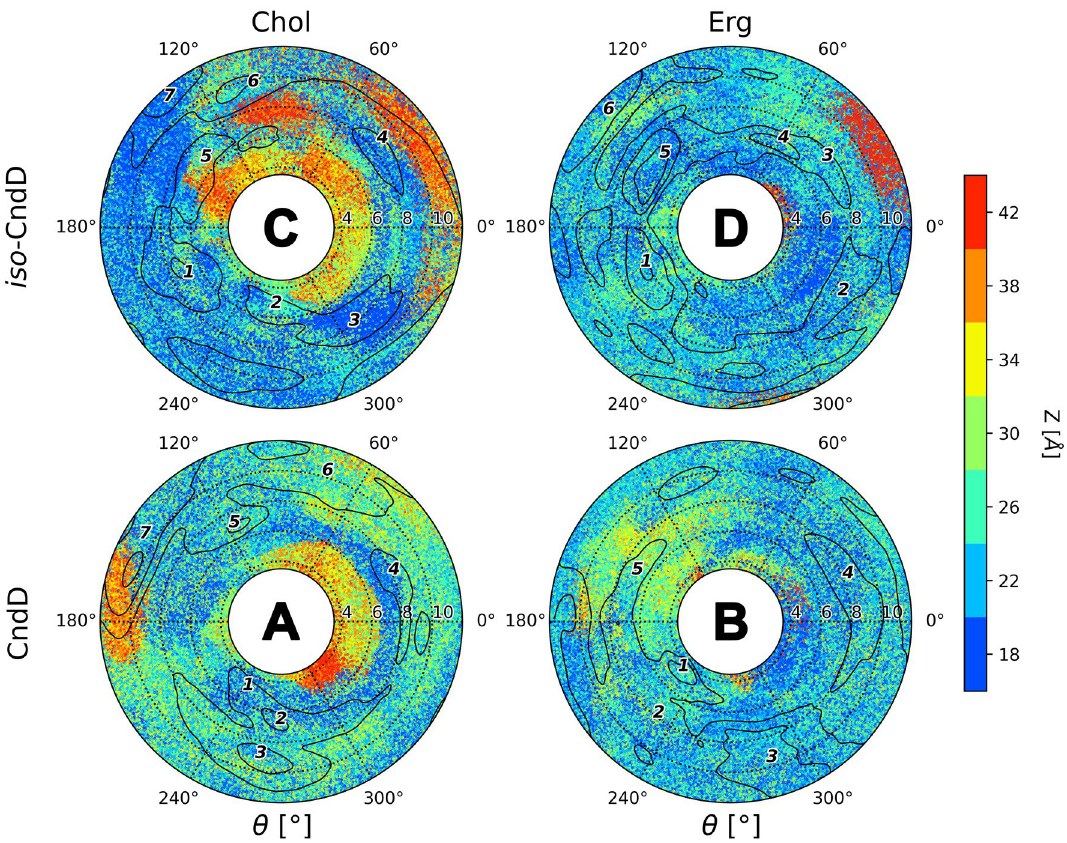
Figure 7. Interactions of candicidin’s D ( A & B ) and iso-candicidin’s D ( C & D ) side chain with an opposite leaflet of a lipid